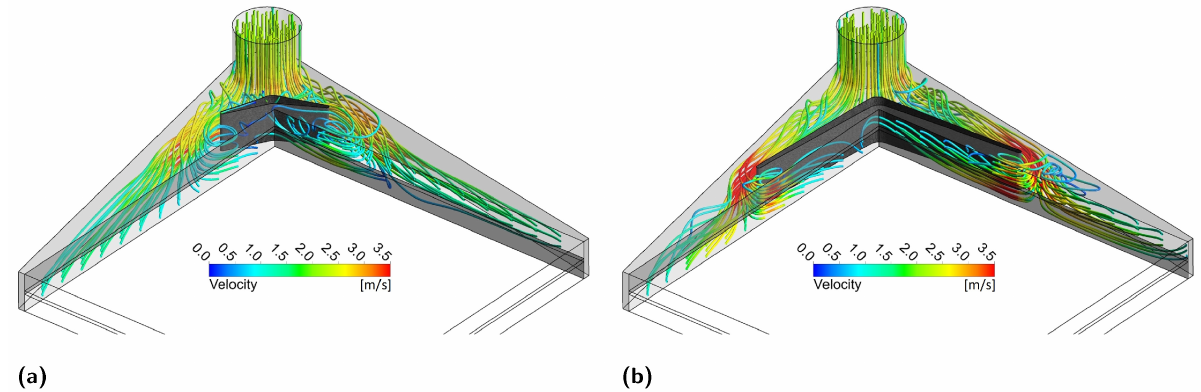
Figure 7. Header with solid baffle: pathlines in the inlet header for u ave = 1.0 m/s, colored by velocity magnitude for ( a ) L b = 1.5 mm (case S-L1) and ( b ) L b = 4.5 mm (case